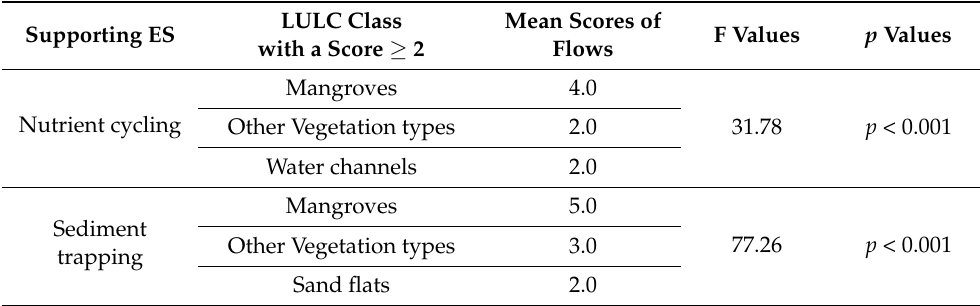
Table 5. Summary statistics of the one-way ANOVA-test for the assessment of flow supporting ES from the LULC with high scores: n = 80 for Ungwana bay,